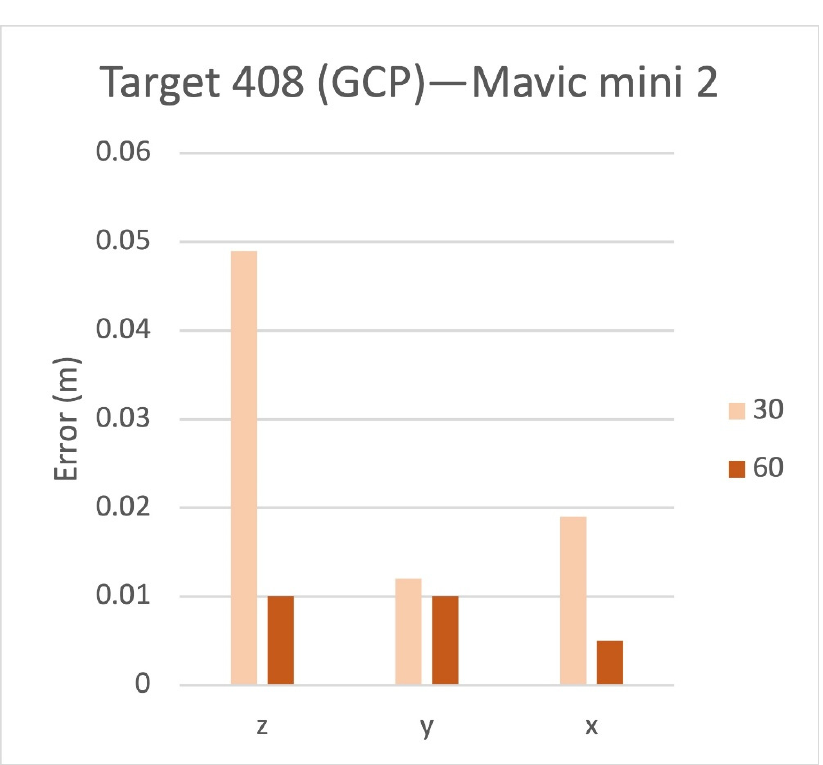
Figure 11. Residuals on CkP 408.